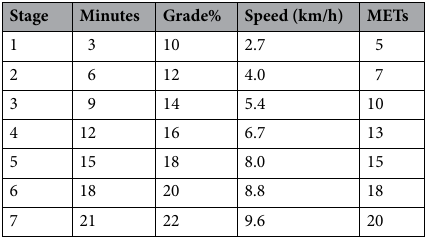
Table 2. Bruce protocol. METs: metabolic